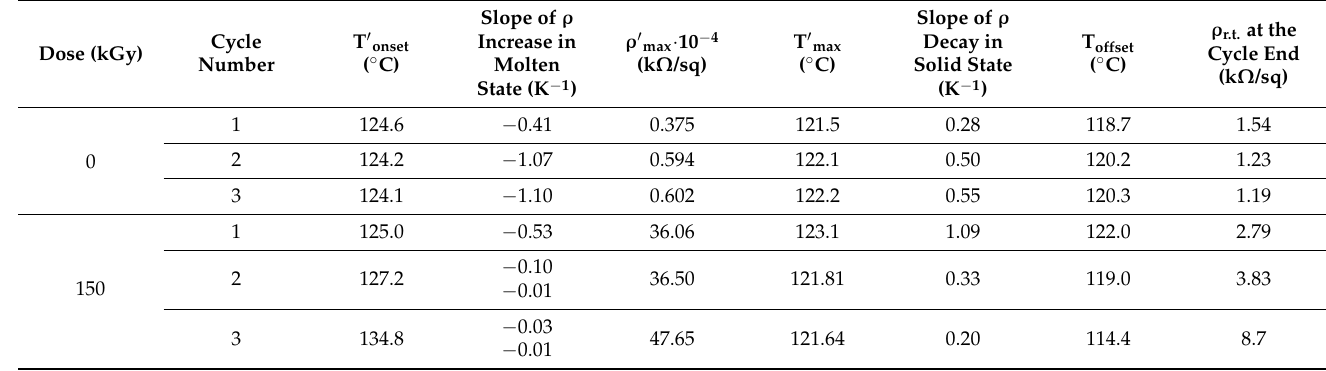
Table 4. Kinetic data of resistivity change on cooling of (CB + Gr)/HD composites.